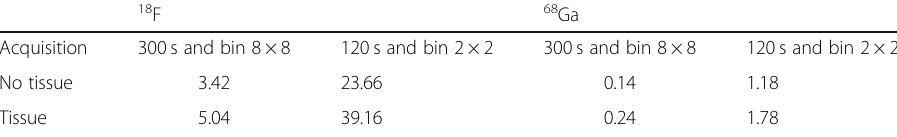
Table 2 Minimal detectable activity concentration (kBq/mL) for 18 F and 68 Ga with SNR = 2, using different acquisition